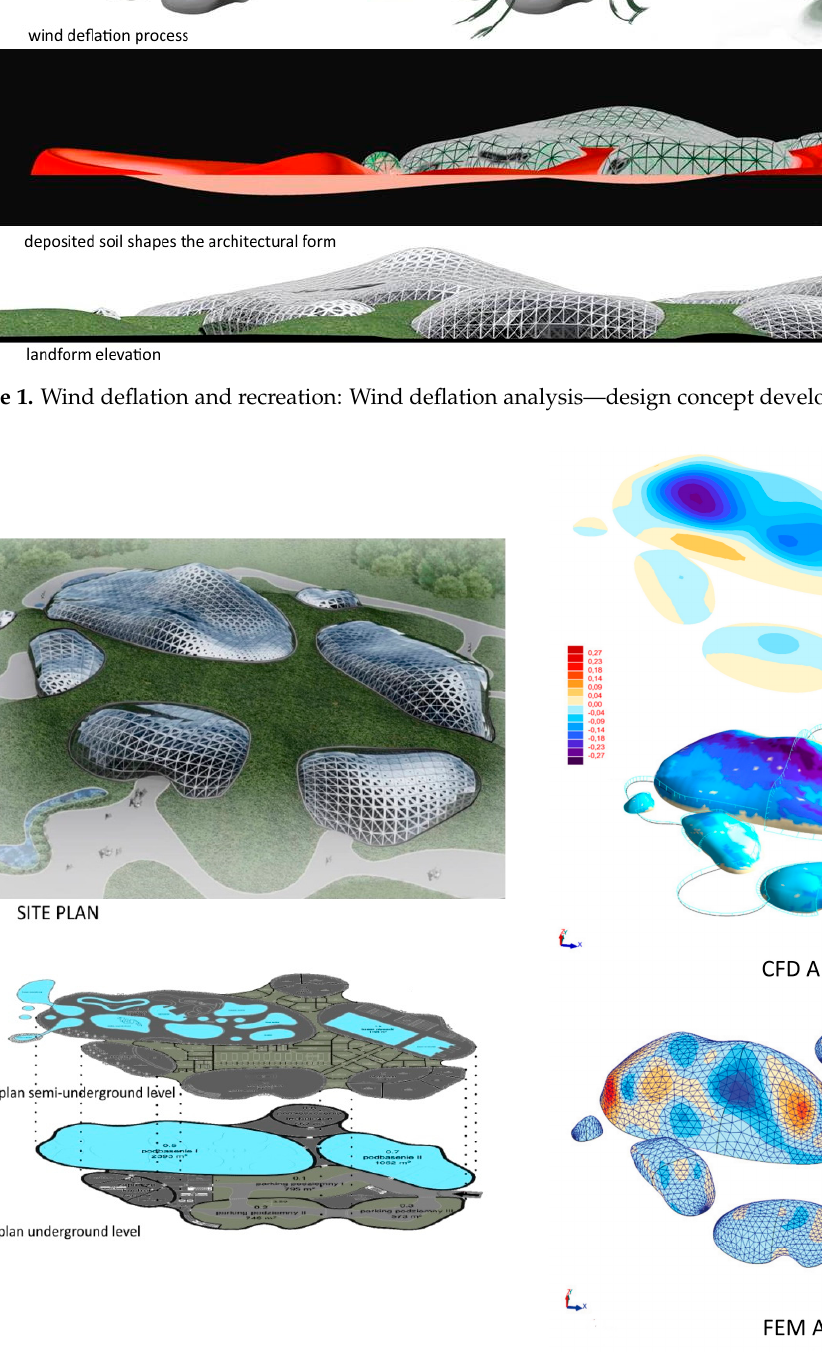
Figure 2. Wind deflation and recreation: CFD analysis and FEM analysis—design concept development (Michał Czapiewski).